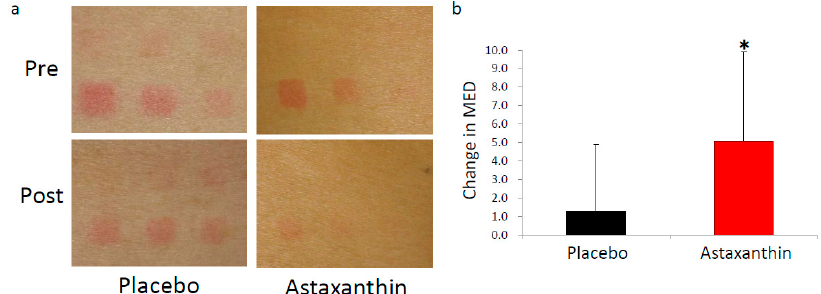
Figure 2. Dietary supplementation with astaxanthin increases the minimal erythema dose. ( a ) Representative imaging of an irradiated area in the placebo group (left) and astaxanthin group (right) before and after supplementation; ( b ) Change in MED from baseline in the placebo group (black) and astaxanthin group (red). * p < 0.05 by Mann–Whitney U -test. Error bars indicate the standard deviation (SD).